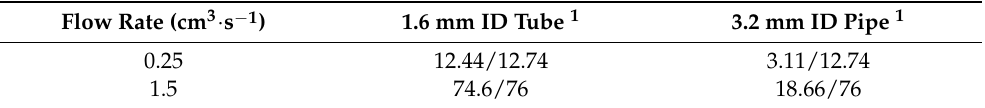
Table 1. Calculated mean velocity at both flow settings and minimum inlet length to ensure laminar flow established within tubes in scanning plane.